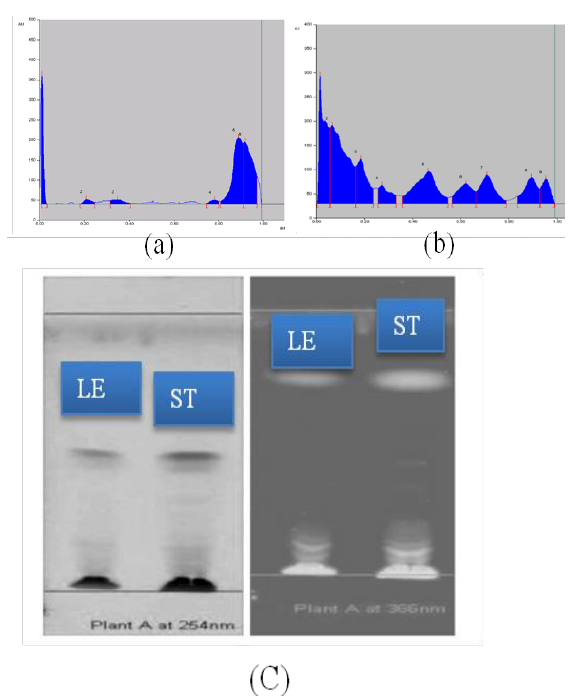
Figure 6: HPTLC profile of extract of Ocimum tenuiflorum with standard eugnol . (a) profil at showed 6 peak at 254nm ;(b) profil at showed 9 peak at 366 nm and (c)Photo documentation report of hydro-alcoholic extract at 254nm and at 366nm LE –leaf extract;ST-Standard.